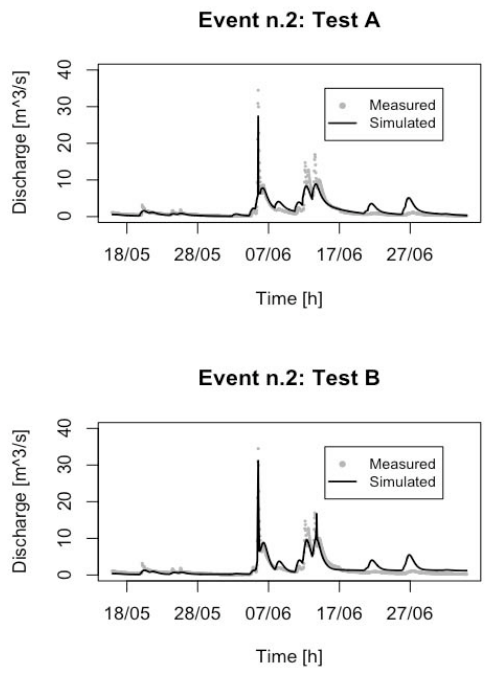
Fig. 4. Event No. 2: test case A at the top and test case B at the bottom.